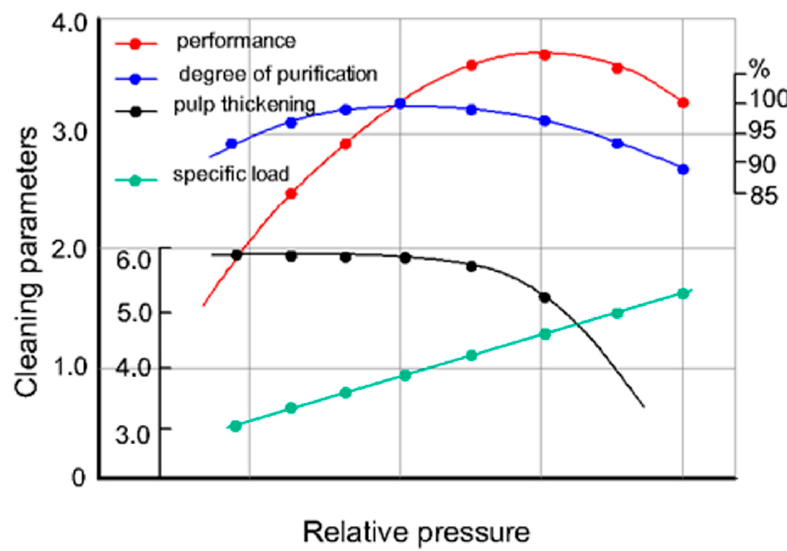
Figure 5. Technological parameters of the “ejector–hydrocyclone” system.